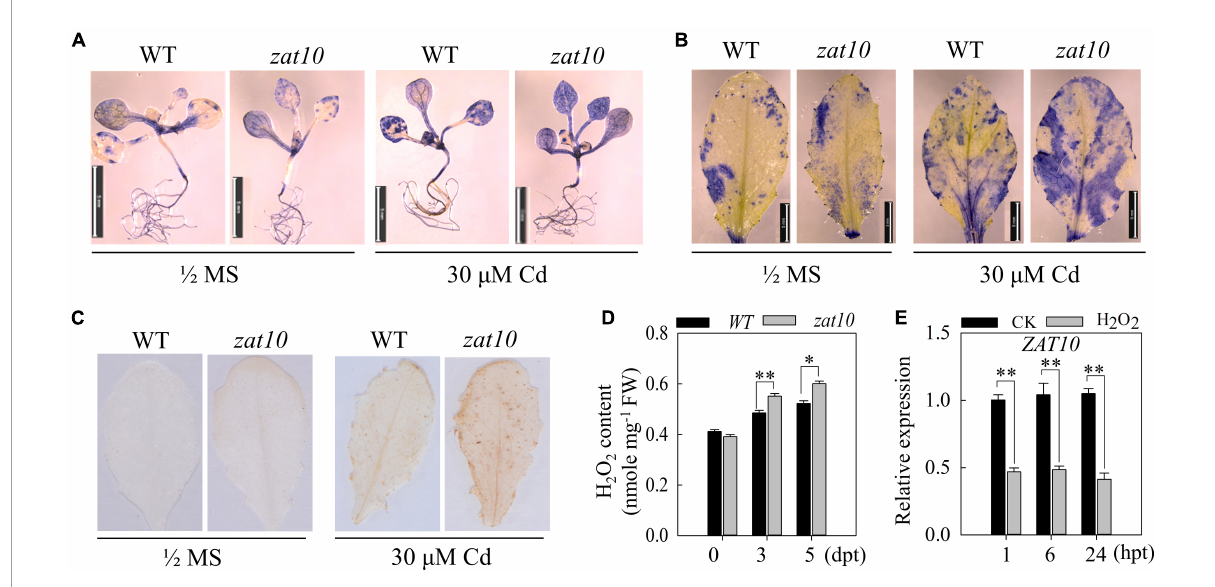
FIGURE3 zat10 plants accumulate more reactive oxygen species under cadmium stress. (A,B) The 2-week-old (A) and 3-week-old (B) wild-type and zat10 plants were treated with 30 µ M CdSO 4 for 24 h, and then the accumulation of ROS in plants (A) and leaves (B) was detected by NBT staining. Bar = 5 mm. (C) Accumulation of H 2 O 2 was detected in the wild type and zat10 leaves under 30 µ M CdSO 4 treatment for 24 h by diaminobenzidine staining. (D) H 2 O 2 concentration in seedlings of the wild type and zat10 mutant under Cd stress. Seven-day-old seedlings grown on 1/2 MS medium were transferred to 1/2 MS medium without or with 30 µ M CdSO 4 for 0, 3, and 5 days, and then were harvested for H 2 O 2 concentration measurements. Means ± SD, n = 3; ∗ P < 0.05 or ∗∗ P < 0.01, Student’s t -test. (E) Expression of ZAT10 was analyzed by qRT-PCR in the wild-type plants at 0, 6, and 24 h post treatment (hpt) with 10 µ M H 2 O 2 . Means ± SD, n = 3; ∗∗ P < 0.01, Student’s t